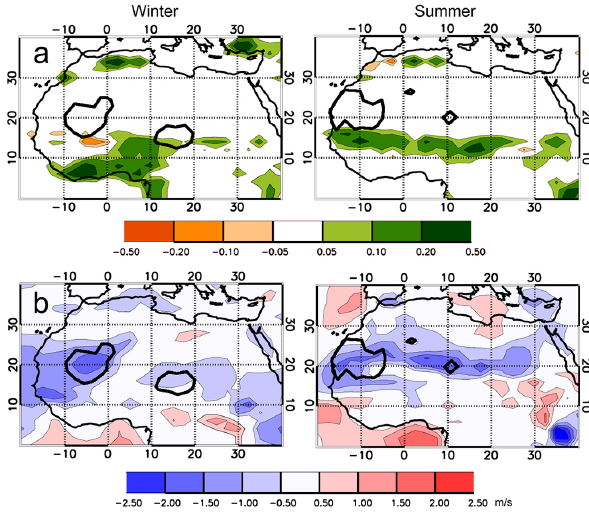
Figure 7. The difference between 2002–2006 and 1982–1986 over North Africa is shown for (a) fractional vegetation cover, repre- sented by the decrease in bareness fraction, and (b) MERRA 10m wind speed. Black contours outline regions where emissions de- crease by more than 0.5Tg per grid